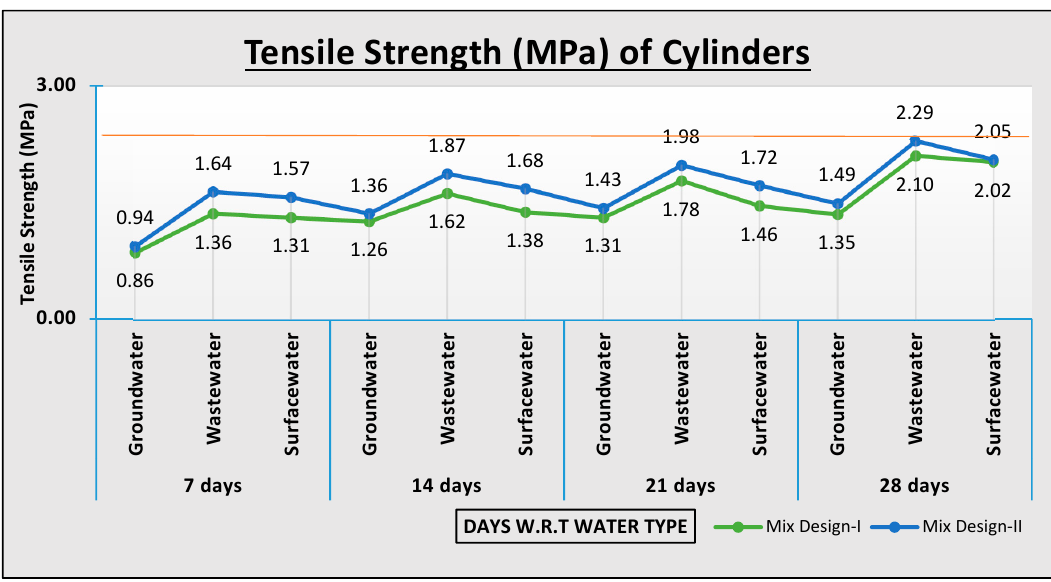
Figure 11. Comparative analysis for the impact of water quality on tensile strength with respect to mix design.